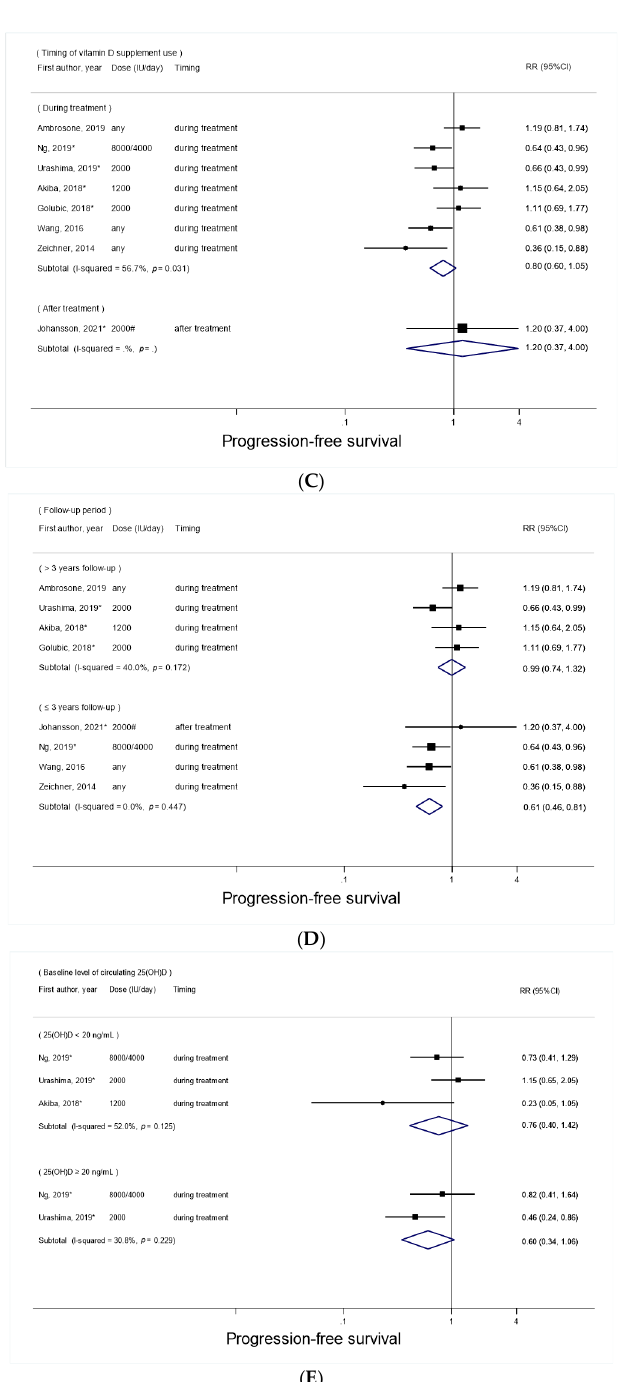
Figure 4. Forest plots for subgroup meta-analyses of post-diagnosis vitamin D supplement use and progression-free survival. ( A ) By study design; ( B ) By cancer type; ( C ) By timing of vitamin D supplement use; ( D ) By follow-up period; ( E ) By baseline level of circulating 25(OH)D. RCTs are marked with *. #: 100,000 IU/50 day, converted to 2000